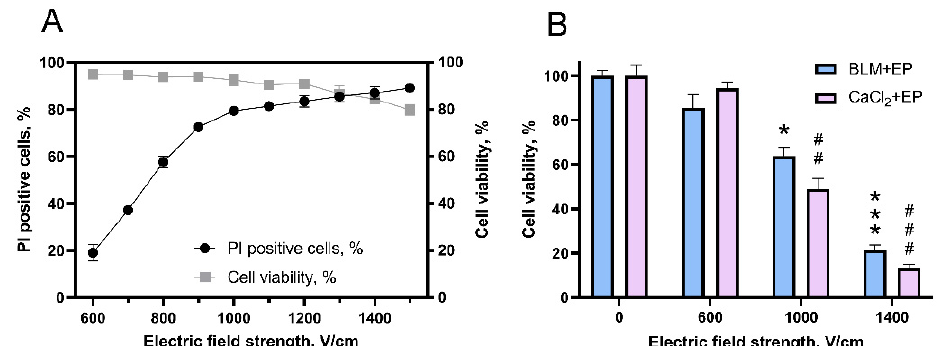
Figure 2. Viability decrease in 4T1 cells induced by bleomycin electrotransfer and calcium electroporation in dependence of electric pulse strength after cell electroporation using a single 100 µs duration pulse. ( A ) The dependence PI electrotransfer and cell viability on electric field pulse strength. ( B ) The dependence of clonogenic cell viability on electric field pulse strength after bleomycin (20 nM) electrotransfer or calcium (1 mM) electroporation. The mean represents 3 independent experiments with 3 repetitions. * and *** symbols represent statistical significance of comparison between BLM + EP group and control (cell not treated with electric pulses), respectively ( p < 0.05 and p < 0.001). ## and ### symbols represent statistical significance of comparison between CaCl 2 + EP group and control, respectively ( p < 0.01 and p < 0.001).